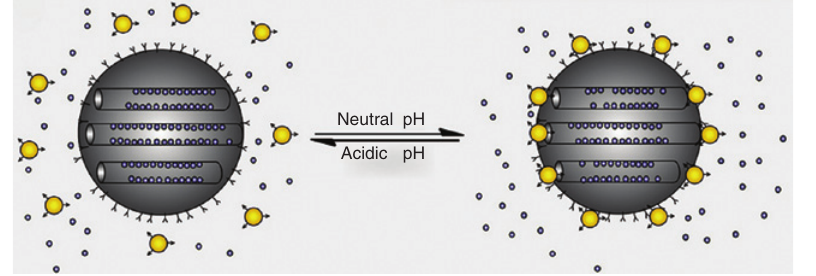
Figure 4: Basic concept of drug release under acidic conditions. Reused from Reference [43] with the permission of